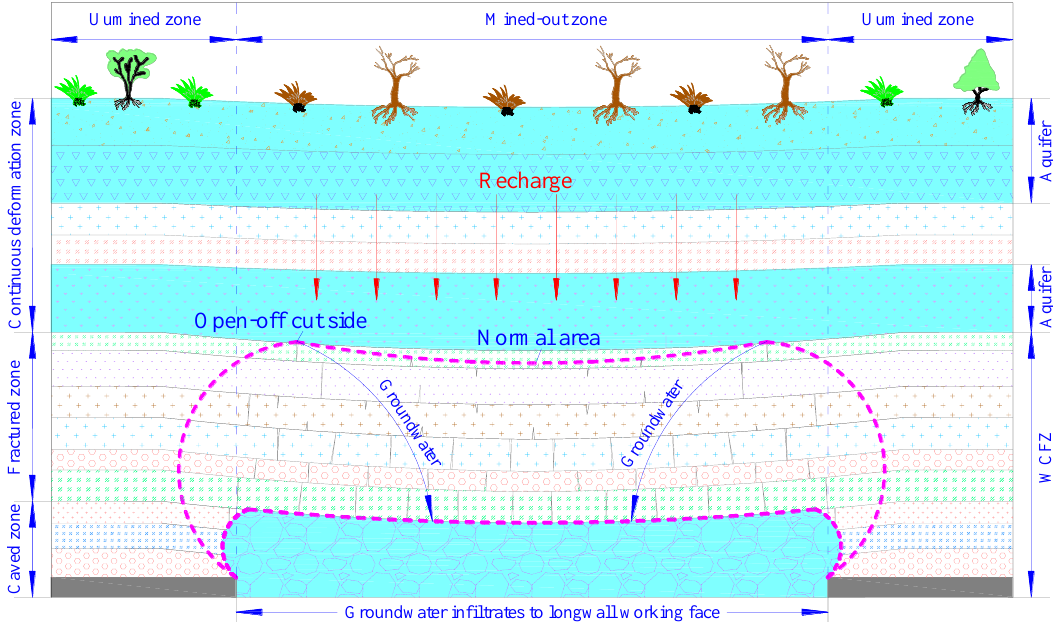
Figure 9. Longwall panel layout.